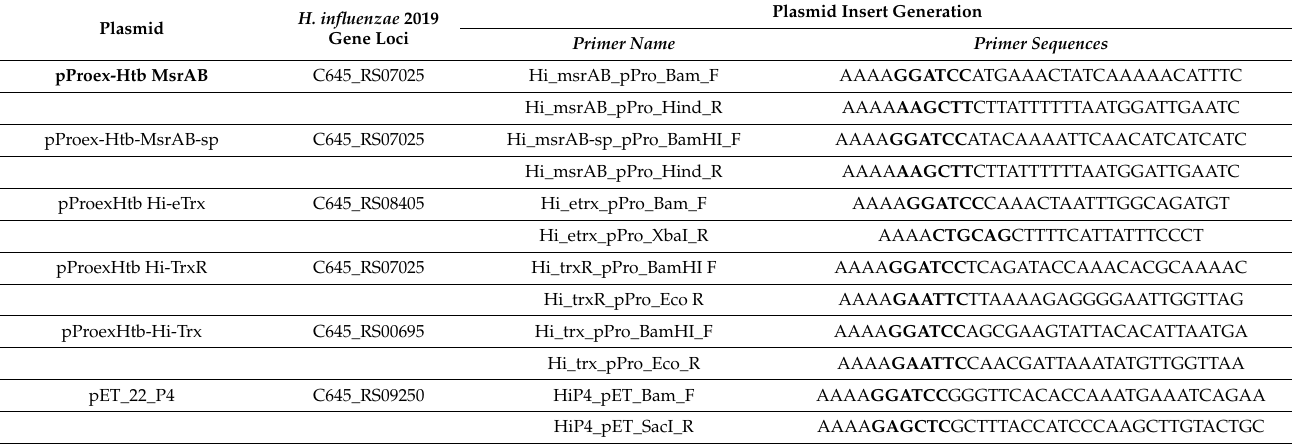
Table 1. Plasmids and